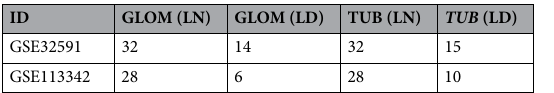
Table 1. Details of the LN cases and LD included in the two gene expression